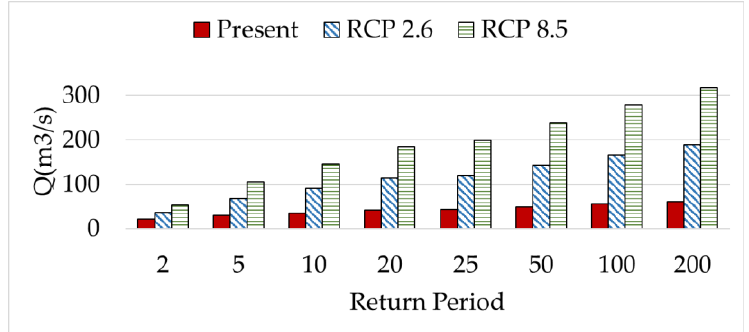
Figure 7. Discharge at the main outlet of the studied basin for 2- to 200-year return period for the present and near future based on the estimated IPF (m 3 s − 1 ) using the Fuller method.